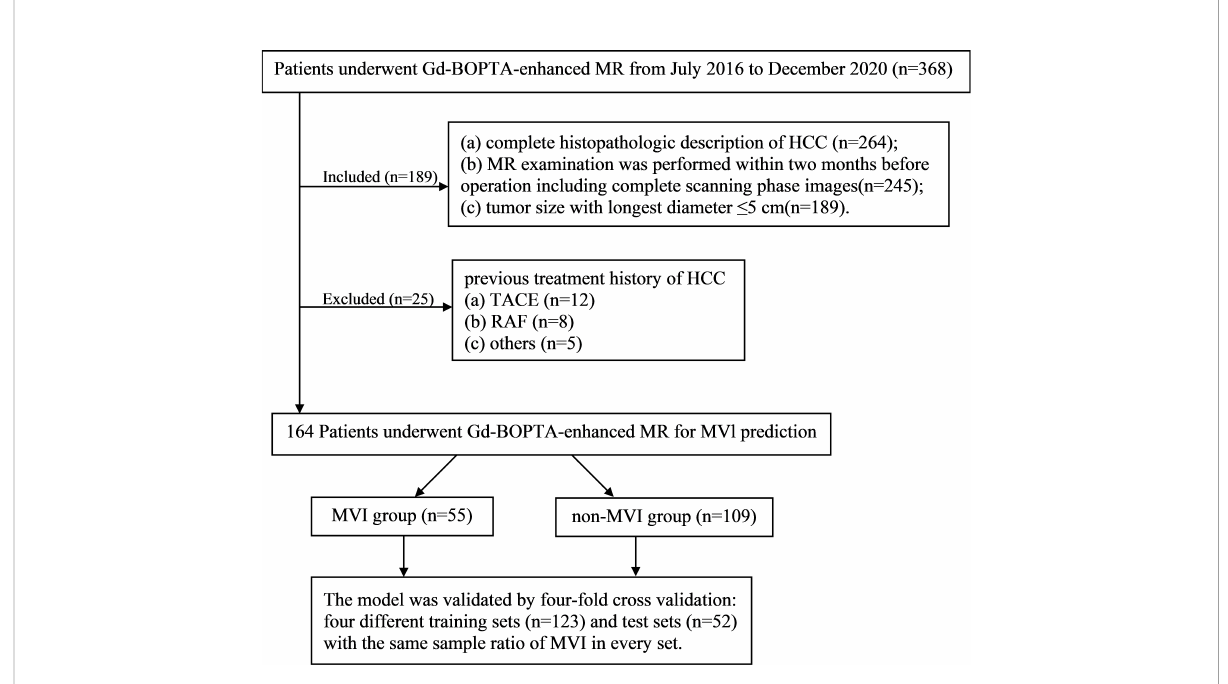
FIGURE 1 The work fl ow of patient selection for this